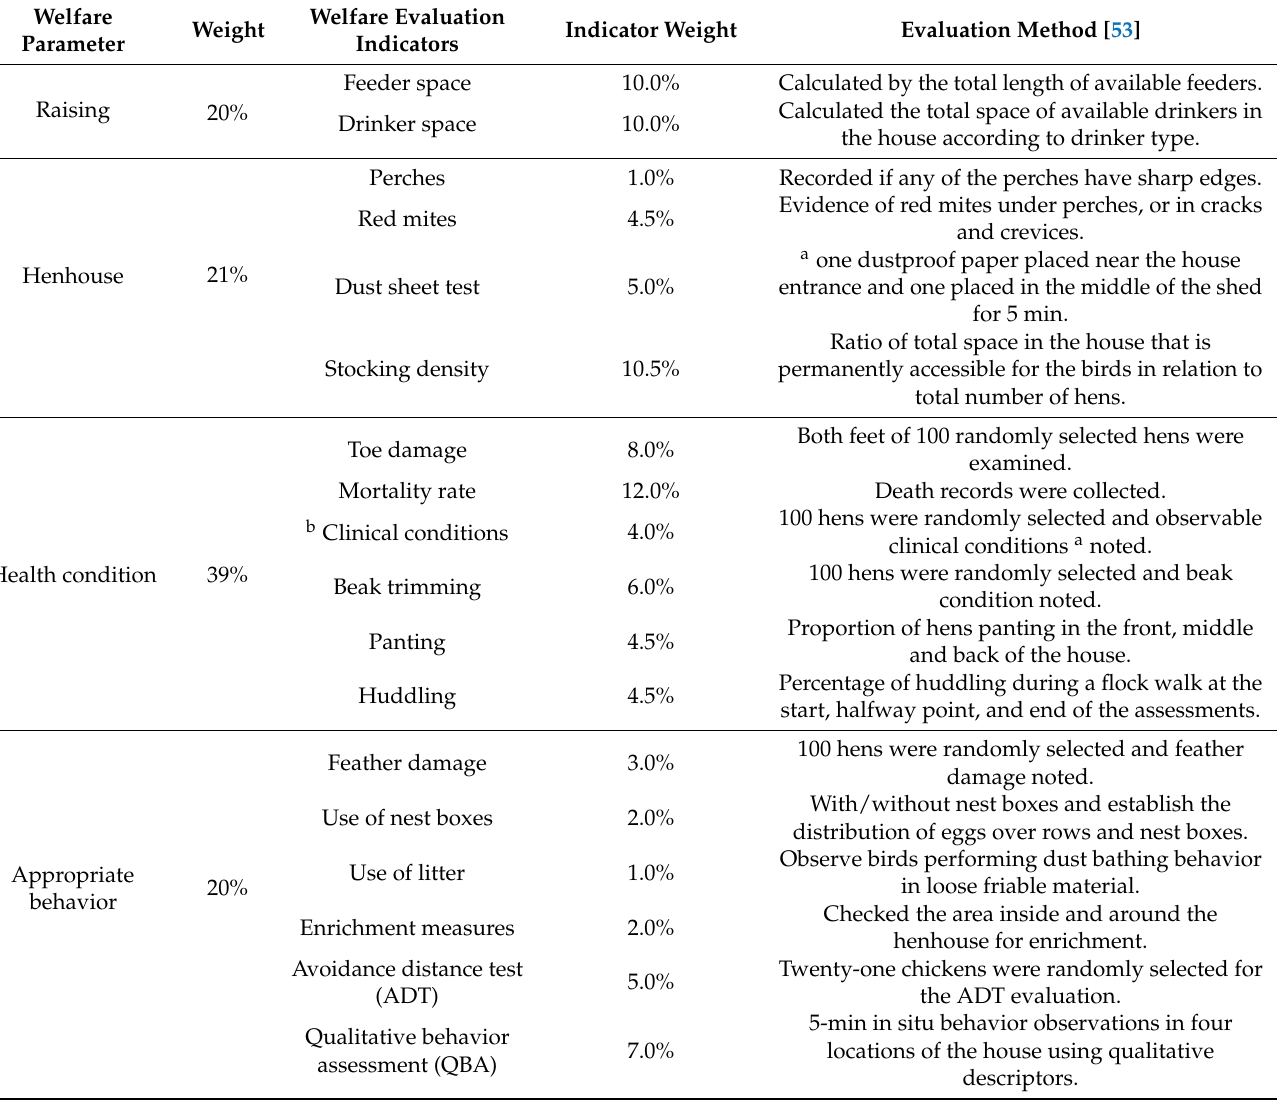
Table 1. The evaluation method and weightings for welfare indicators in the calculation of farm welfare